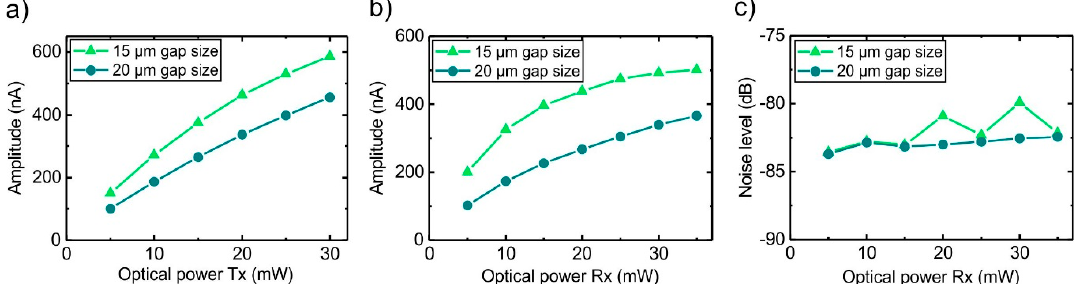
Figure 4. Characterization of the emitter and receiver part of the THz transceiver for 15 and 20 µm wide photoconductive gaps. ( a ) The emitted THz pulse amplitude as a function of optical power at the emitter, detected by a separate state-of-the-art THz receiver. ( b ) The detected THz pulse amplitudes emitted from a state-of-the-art emitter and ( c ) the spectral noise level for frequency components >7 THz as a function of optical power at the receiver part. As shown, the smaller photoconductive gap leads to higher emitted and detected THz pulse amplitudes while the spectral noise floor remains as low as for the larger gap size.